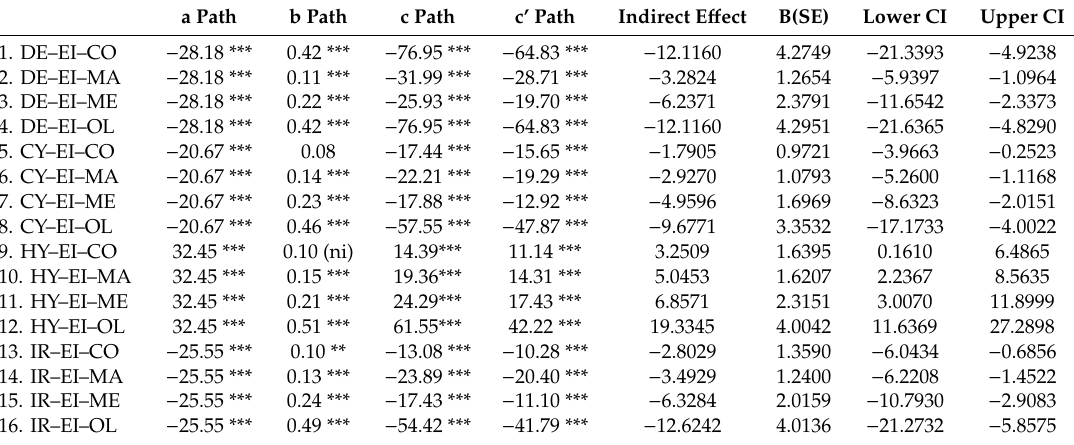
Table 3. The role of emotional intelligence in the relationship between dimensions of temperament and sense of